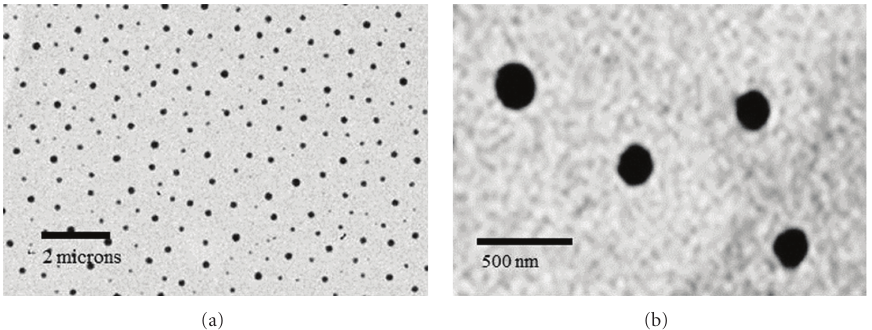
Figure 2: Physicochemical characteristics of PLA nanocapsule [polyHb-Tyr]. (a) TEM of PLA nanocapsule [polyHb-Tyr] at low mag- nification. (b) TEM of PLA nanocapsule [polyHb-Tyr] at high magnification.